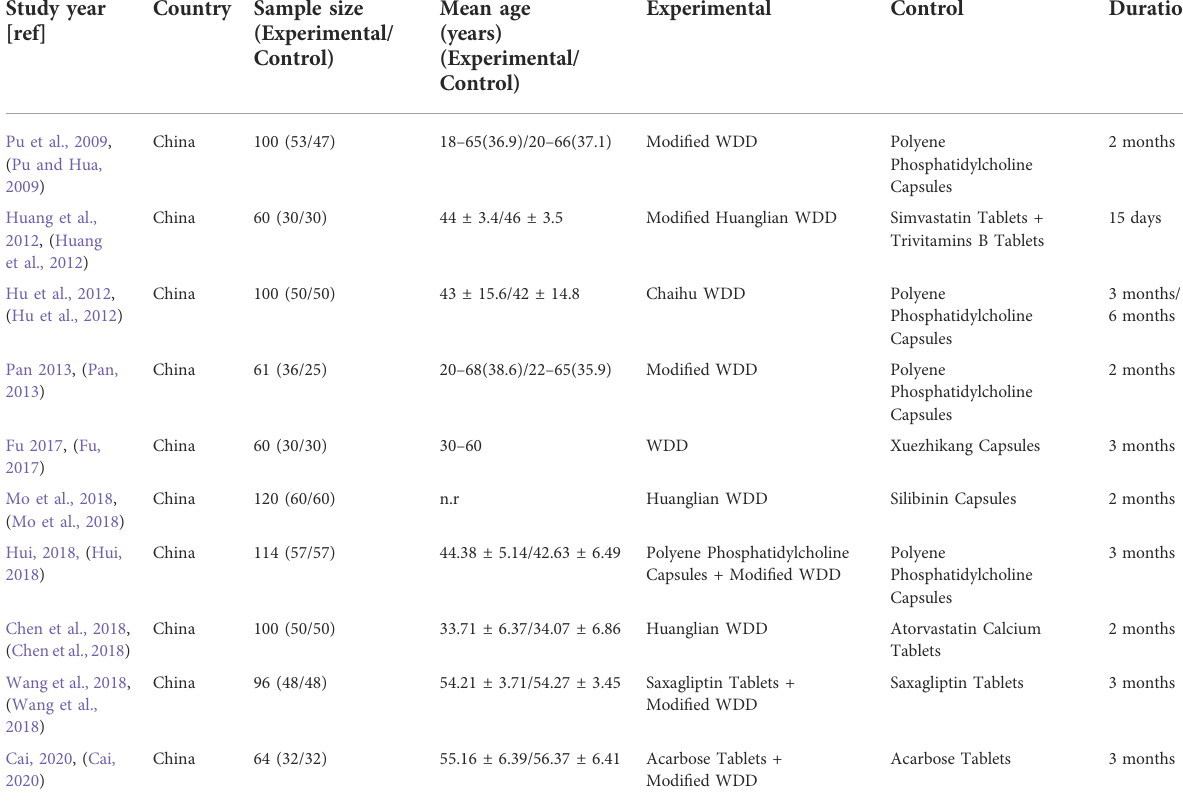
TABLE 1 Summary of RCTs that investigated WDD for